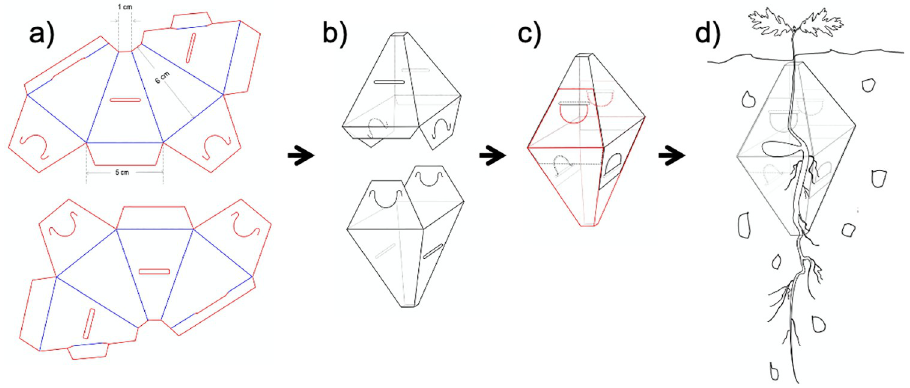
Fig 4. Seed shelters to be used to protect acorns from small vertebrate predators. Before assembling the two units, they are filled with local soil and an acorn is placed in the middle. Reproduced from [12] with permission from